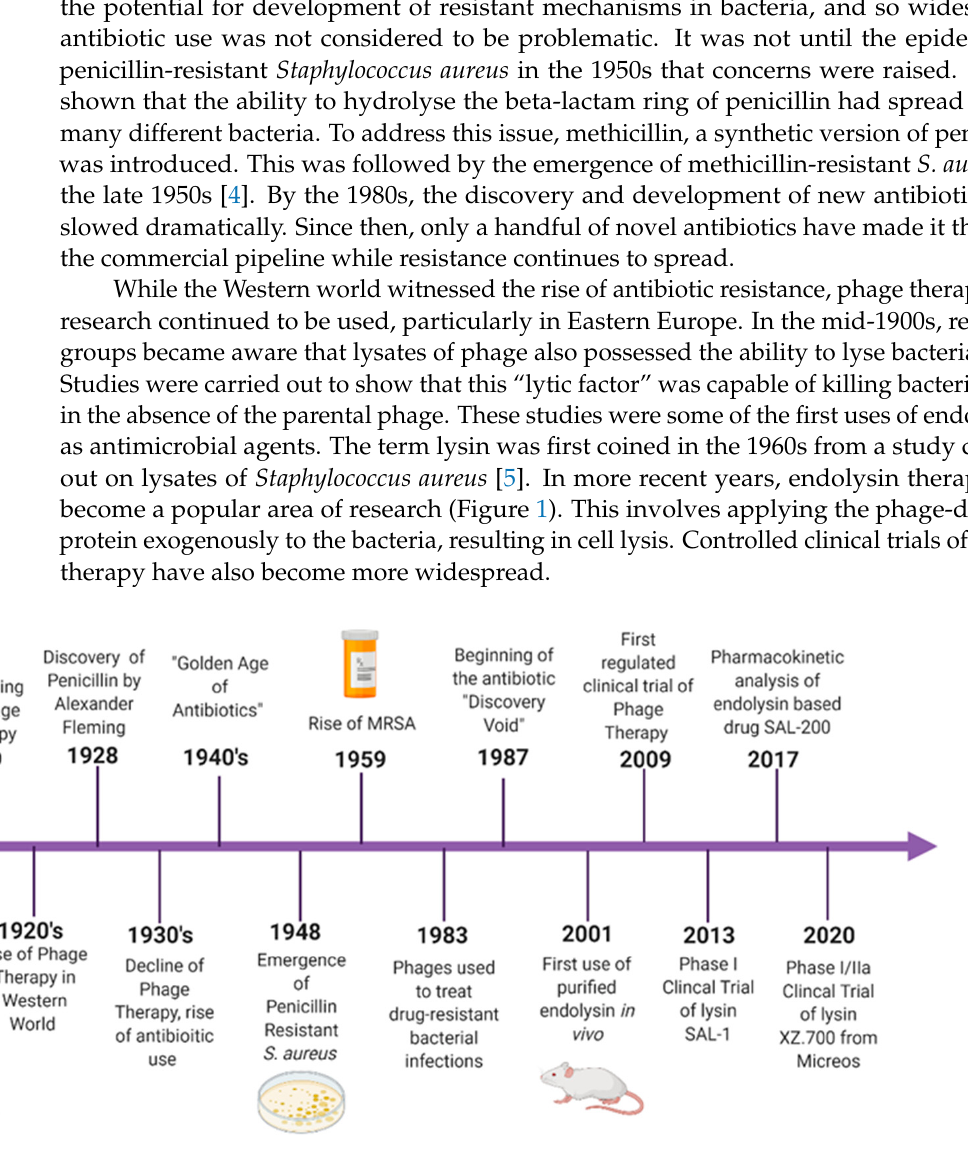
Figure 1. Timeline of Phage Therapy. Outlined is the history of phage and endolysin therapy vs. antibiotic therapy, from the discovery of bacteriophage to the present day.